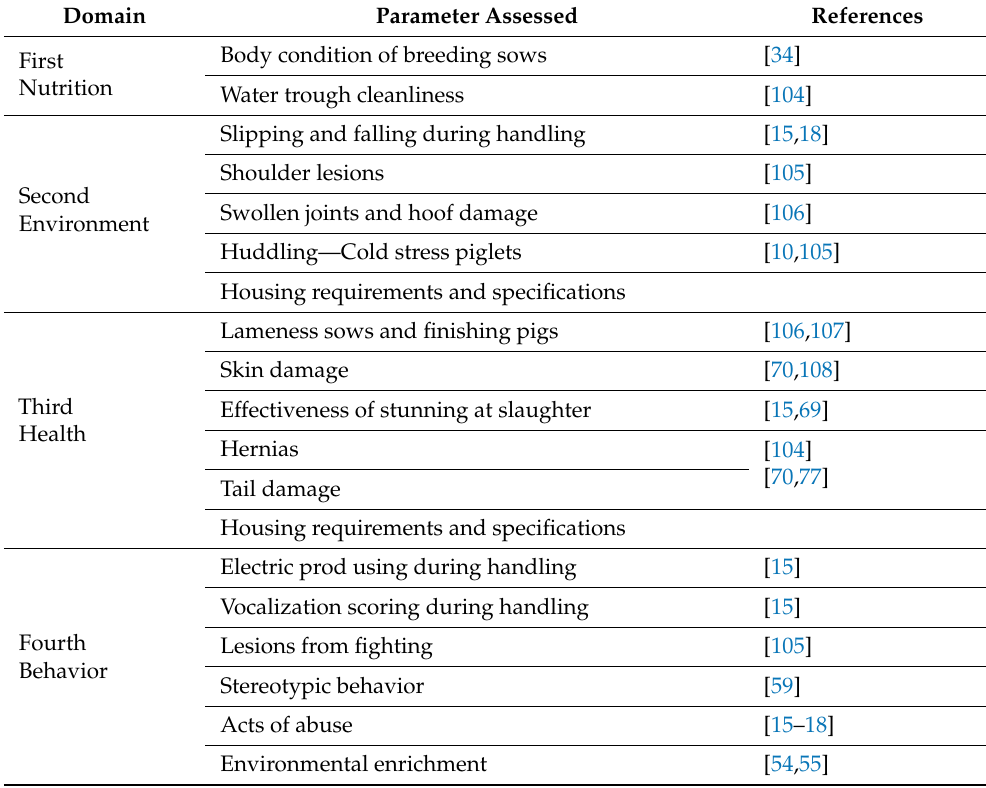
Table 3. Key Welfare Indicators for Pigs.